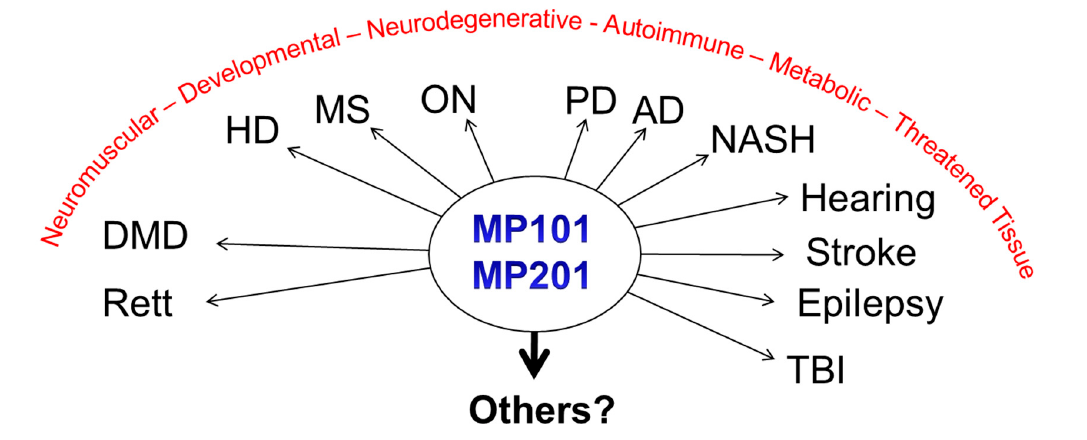
Figure 7. DNP as a Broad-Spectrum Treatment. DNP (MP101) or the prodrug of DNP (MP201) has been tested in disease models of acute and chronic studies with a known and unknown genetic cause that representing pediatric, adult and elderly indications with statistically positive outcomes. The indications also present diseases of neuromuscular disorders, development, neurodegeneration, autoimmune, metabolic and trauma. The future will help to determine the limitations of the pharmacology, but given the findings, it appears that DNP may be a broad-spectrum treatment to many disorders.